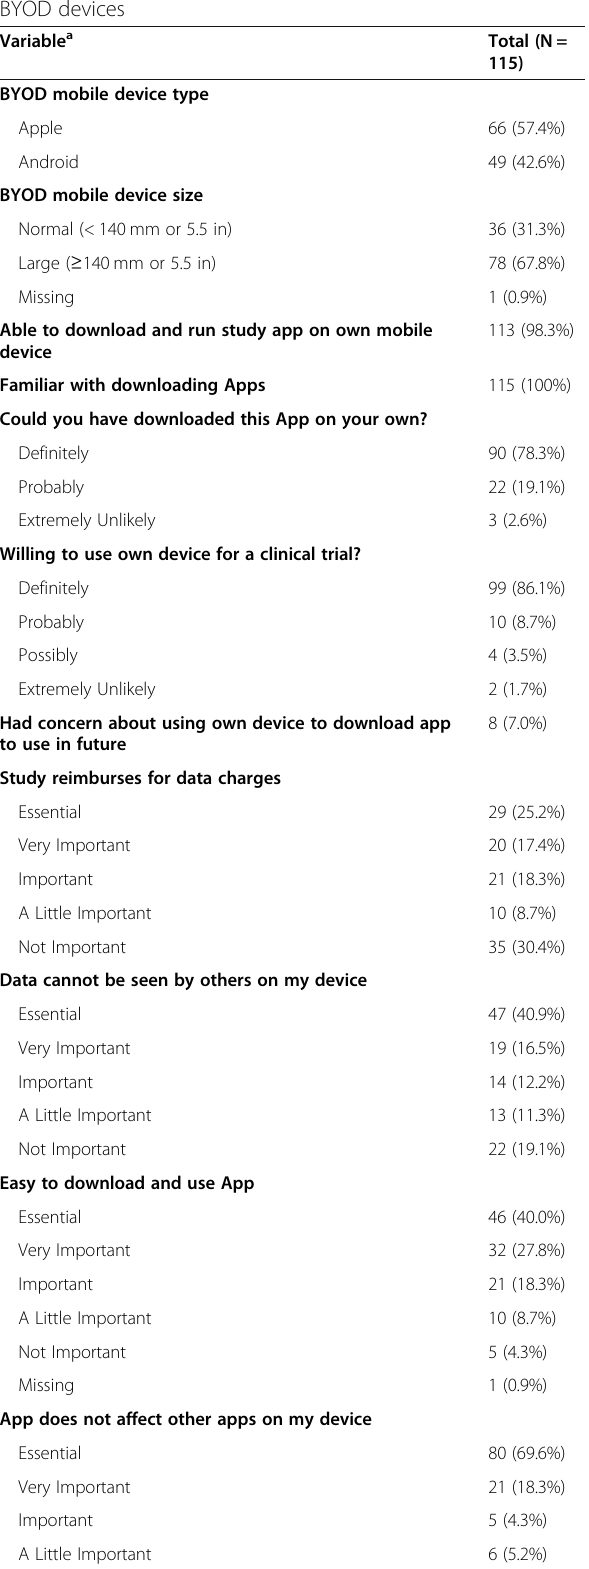
Table 2 Patient familiarity, preferences, and attitudes towards